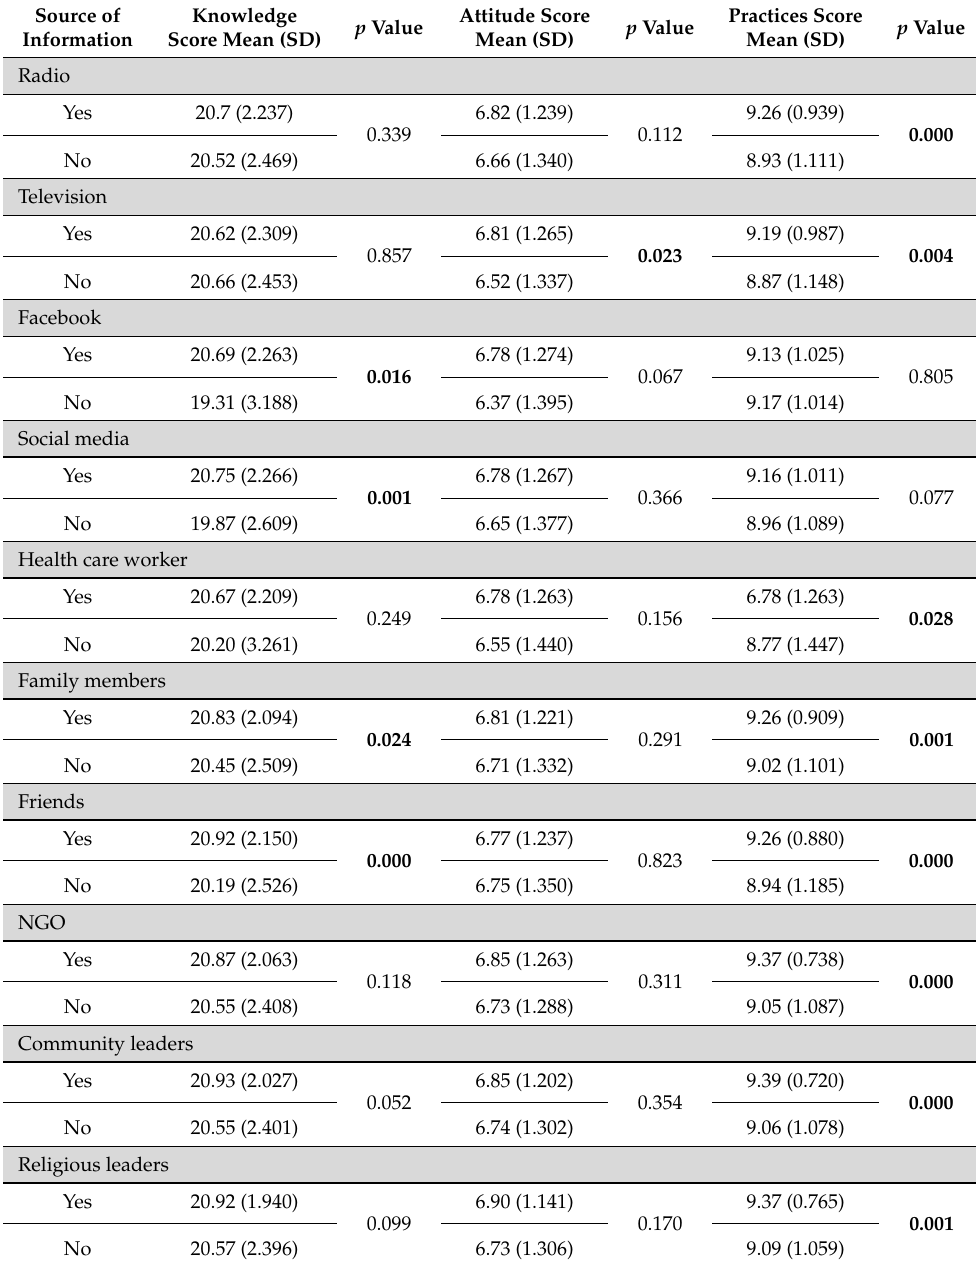
Table 2. Association between source of information and knowledge, attitude and practice